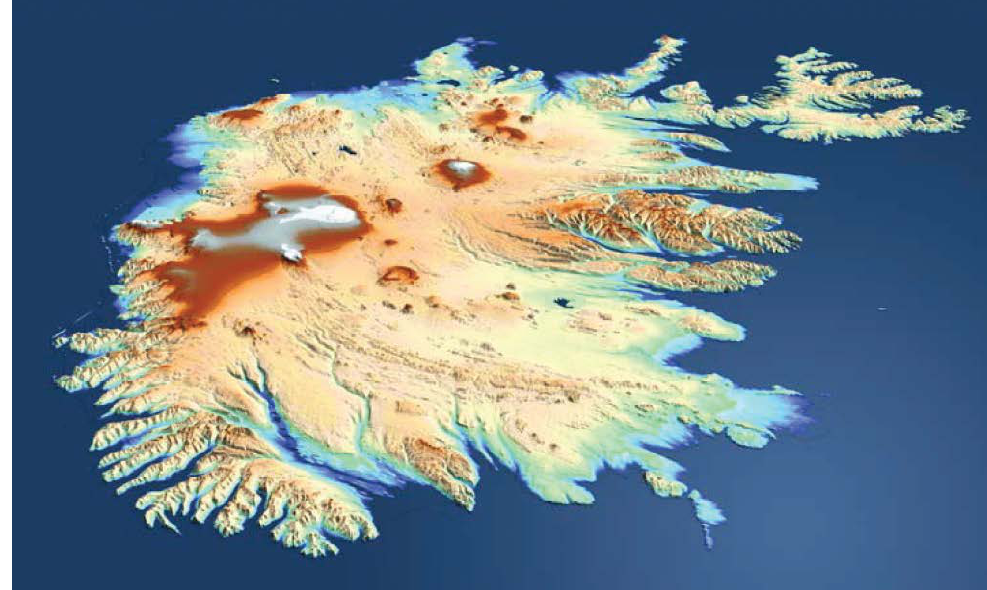
Figure 6: TanDEM-X DEM mosaic of Iceland derived from the first